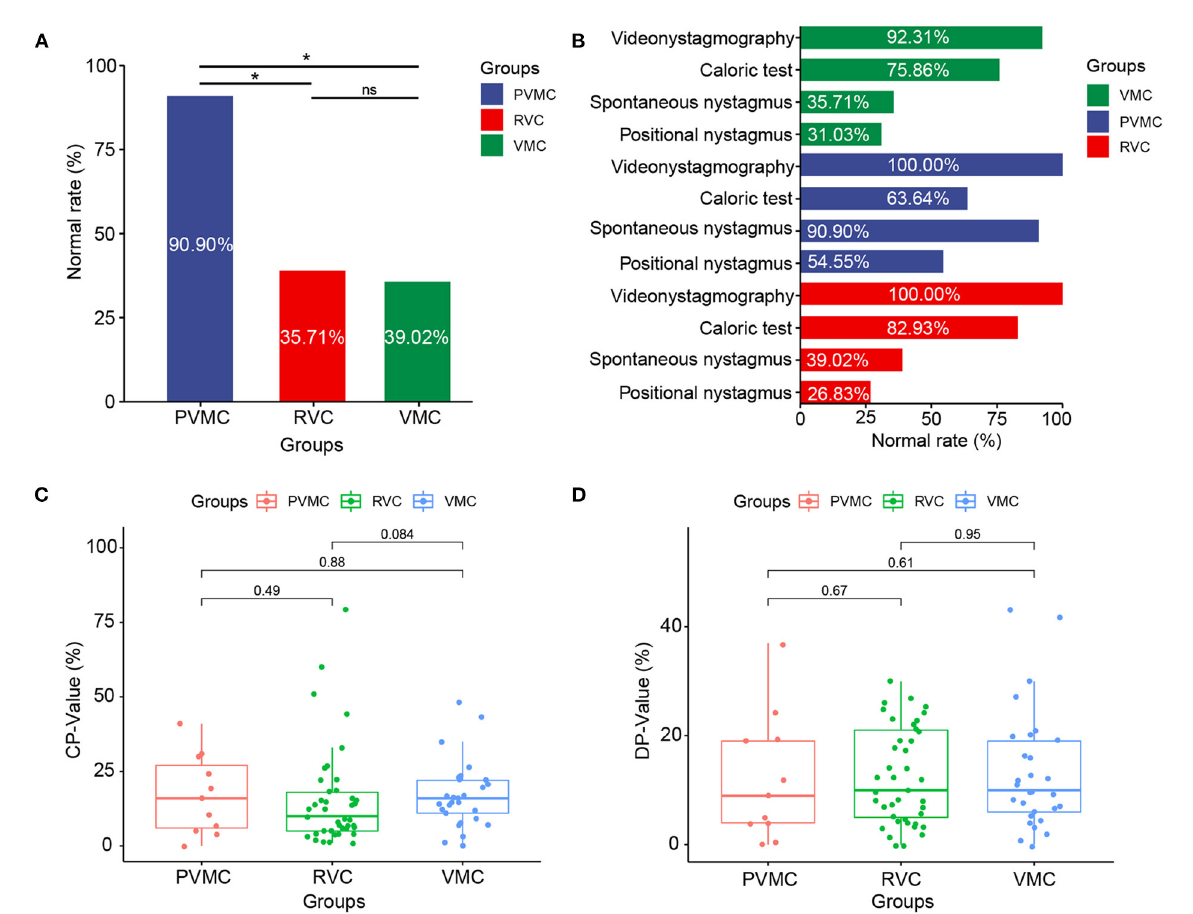
FIGURE1 Characteristics of the VNG results. (A) Normal rate of spontaneous nystagmus results in patients with VMC, PVMC, and RVC. (B) Normal rate of videonystagmography, caloric test, positional nystagmus, spontaneous nystagmus results in patients with VMC, PVMC, and RVC. (C) Results of CP-value in caloric tests among the three groups, and (D) Results of DP-value in caloric tests among the three groups. * P ≤ 0.05; ns, P > 0.05. VMC, vestibular migraine of childhood; PVMC, probable vestibular migraine of childhood; RVC, recurrent vertigo of childhood; CP, canal paresis; DP, directional preponderance.